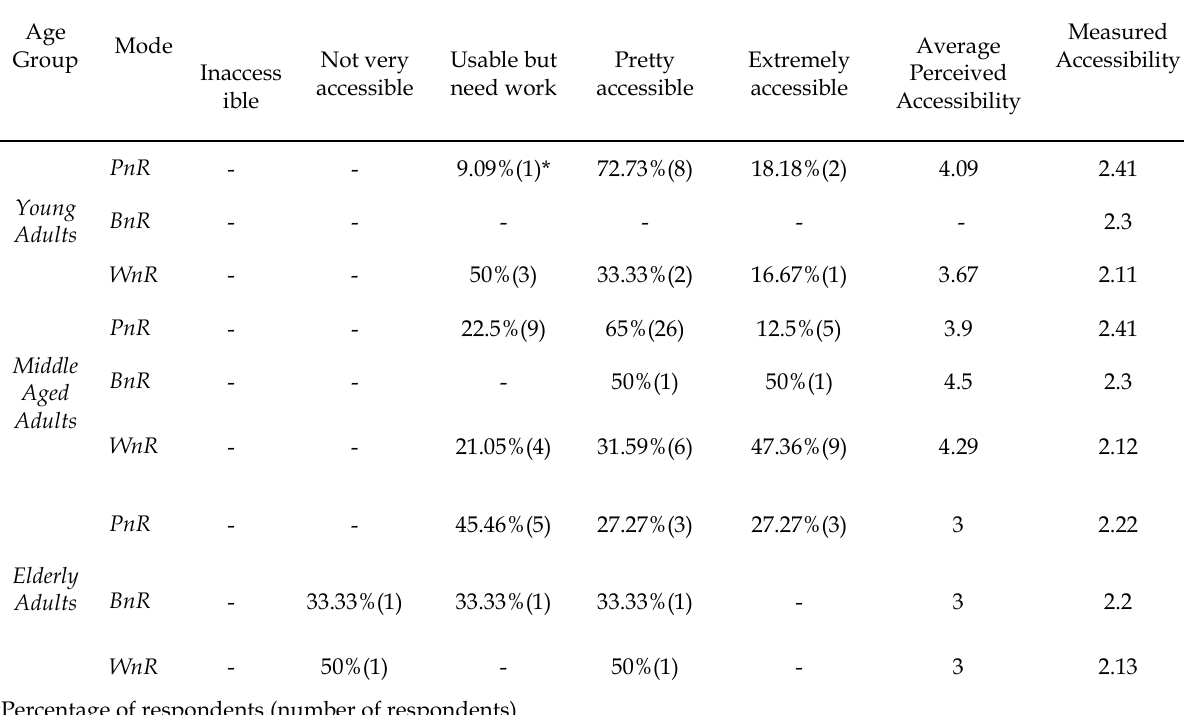
Table 6. Comparison between perceived and measured